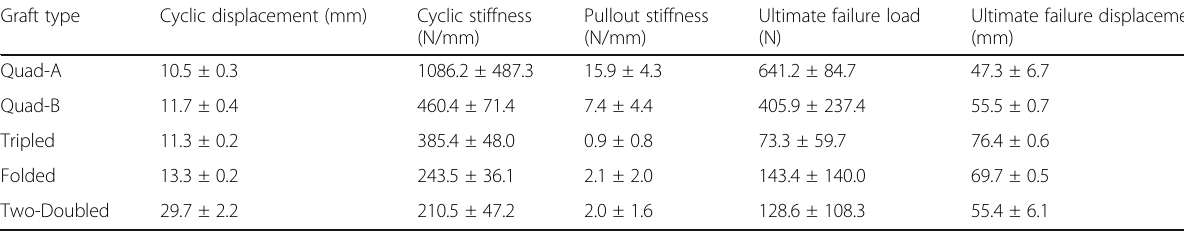
Table 3 Biomechanical Properties of ACL/PCL Graft Constructs; n = 10 in each graft group Graft